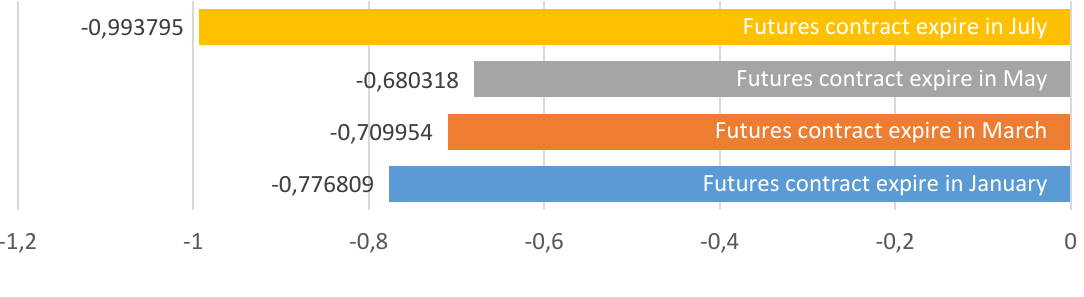
Figure 3. ETC ( ) ω coefficient of Robusta futures